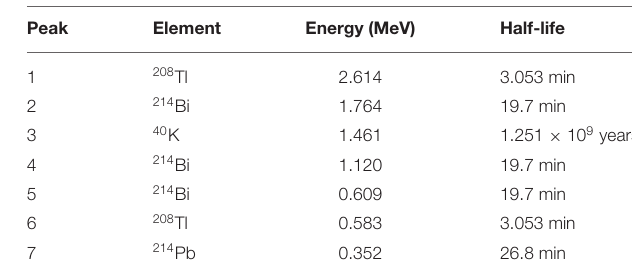
TABLE 2 | Natural radioactivity background: identified